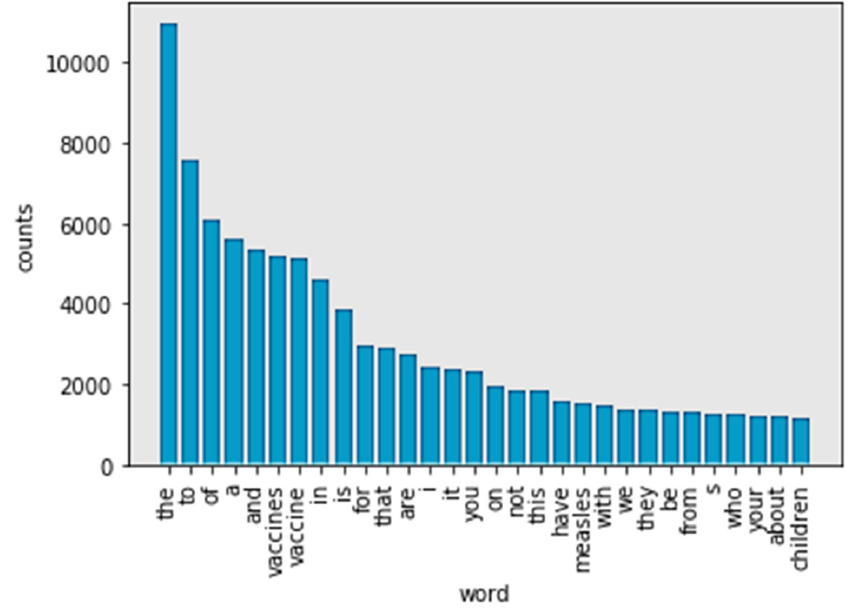
Figure 3. Top 30 frequency words in tokens.